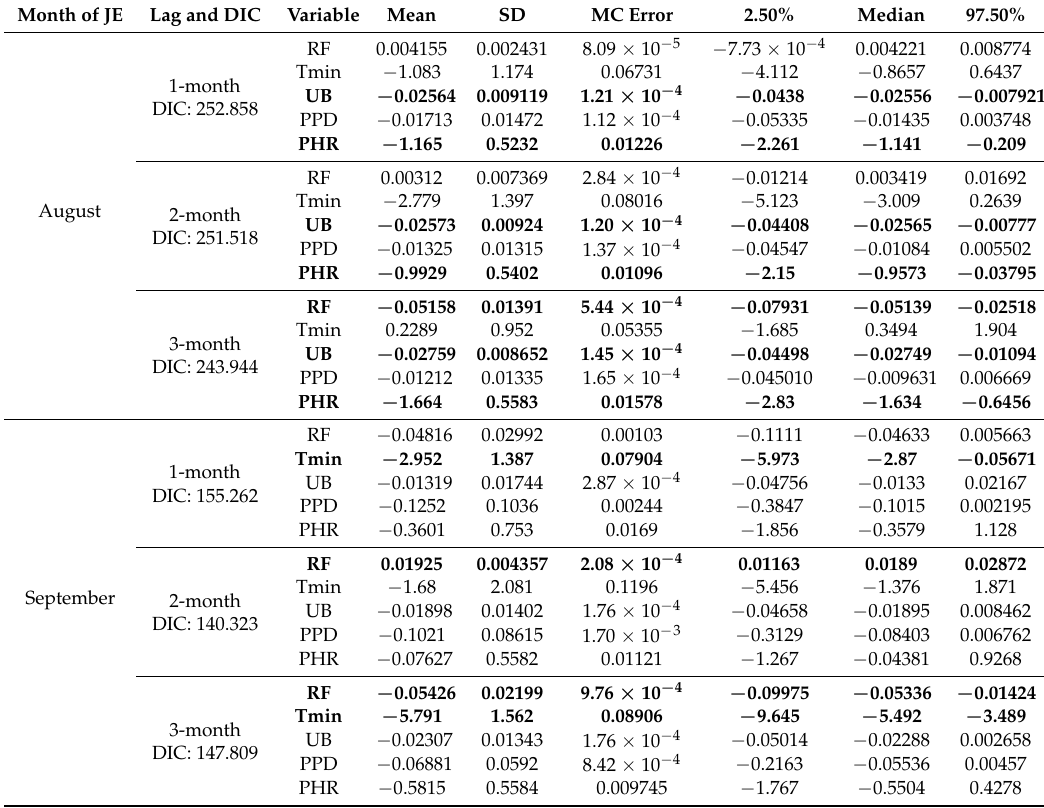
Table 5. Meteorological, socio-economic factors and JE incidences (Model II: